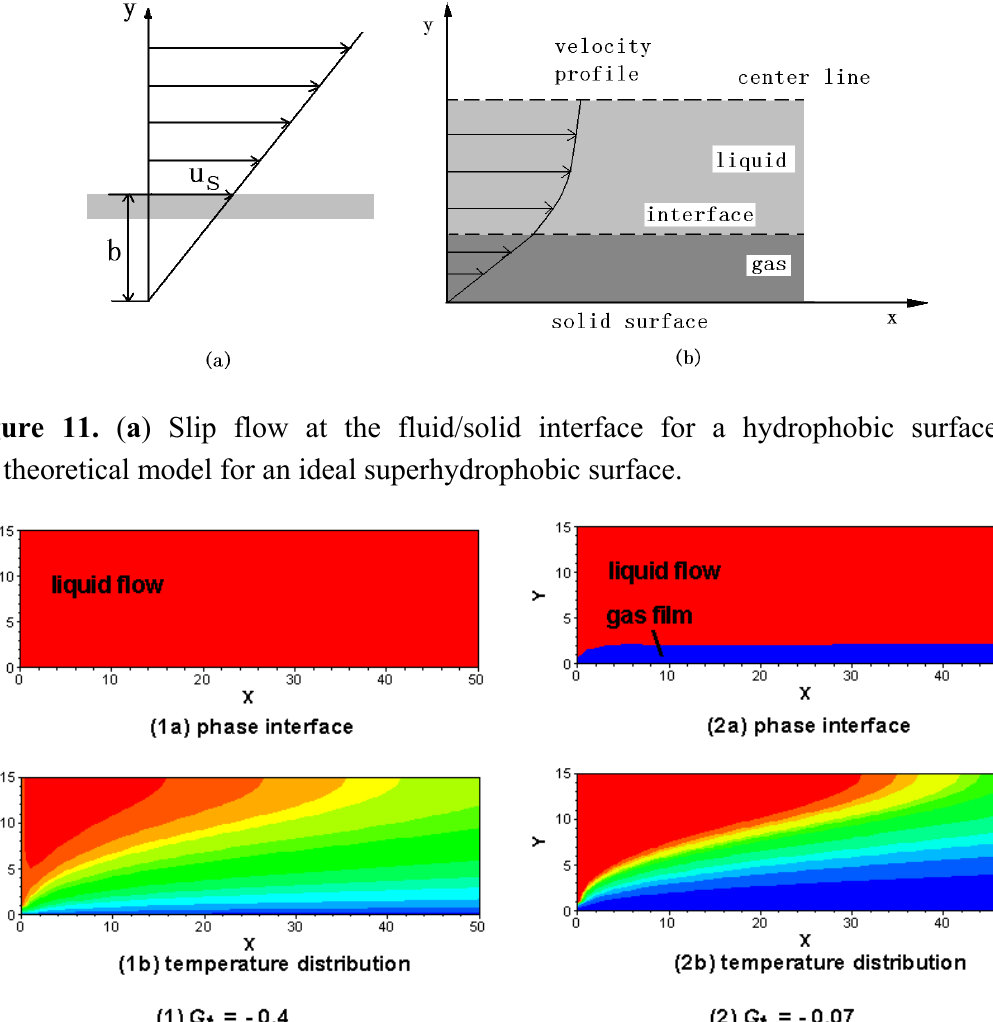
Figure 12. The local enlargement of ( a ) phase interface and ( b ) temperature distribution for the channel flow with smooth surfaces when ( 1